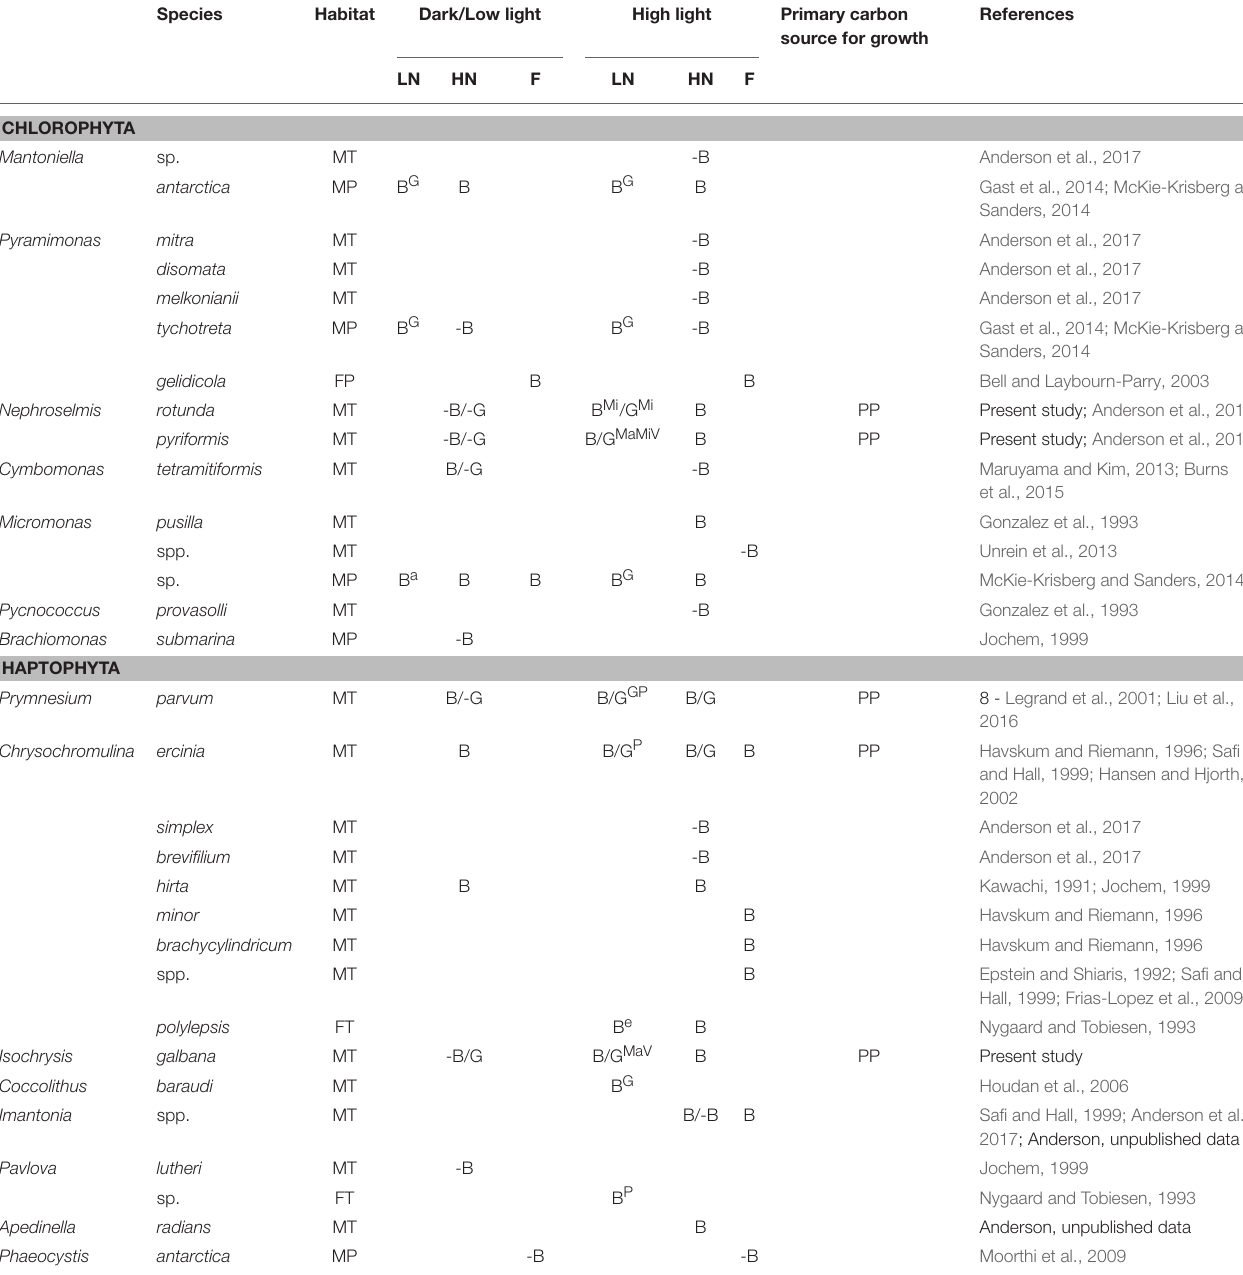
TABLE 1 | Chlorophyte and haptophyte genera for which bacterial ingestion (B) and/or mixotrophic growth (G) has been tested under different regimes of light (dark or low light vs. high light) and nutrients [low nutrient concentrations (LN), high nutrient concentrations (HN) or field samples with unknown nutrient concentrations